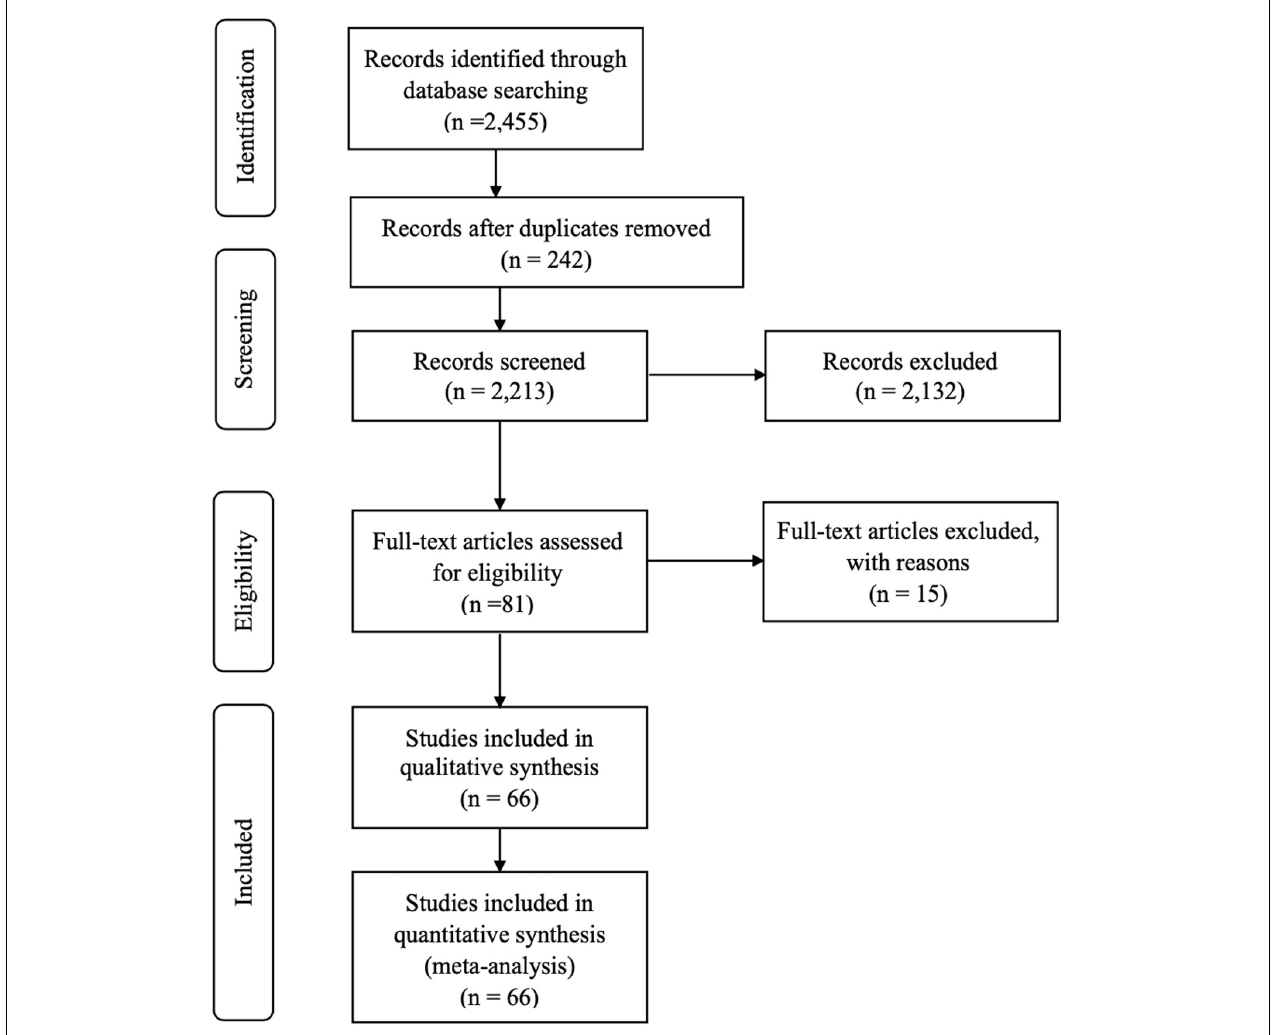
FIGURE 1 | PRISMA flow diagram of the systematic review from initial search and screening to final selection of publications to be included in the meta-analysis. The 66 selected articles for inclusion in the meta-analysis contained multiple experiments; therefore, 87 experiments were